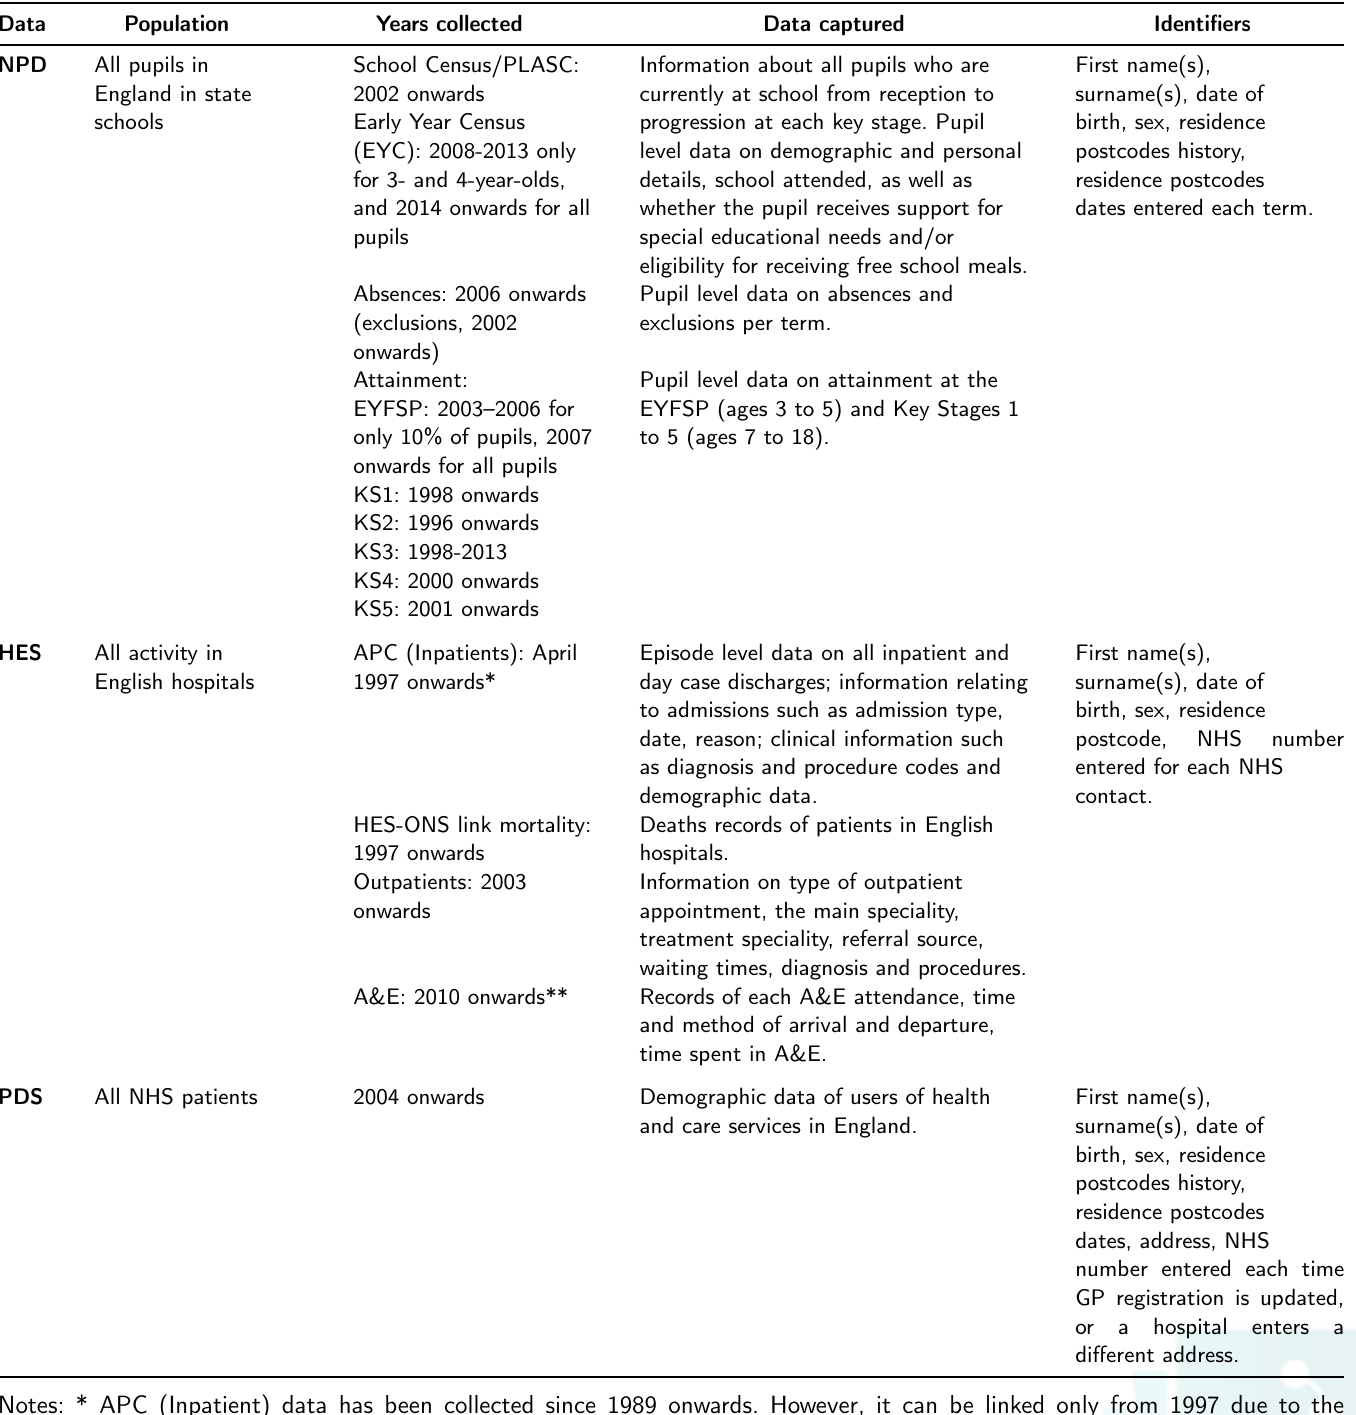
Supplementary Table 1: Description of data resources used in the